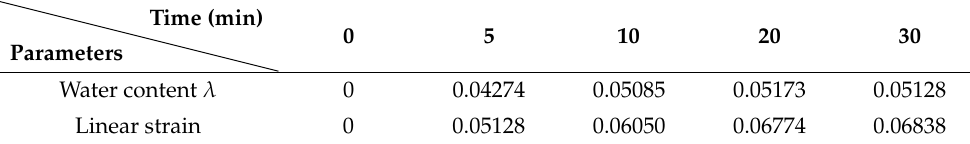
Table 1. Water content and linear strain of the membrane tested at 80 ◦